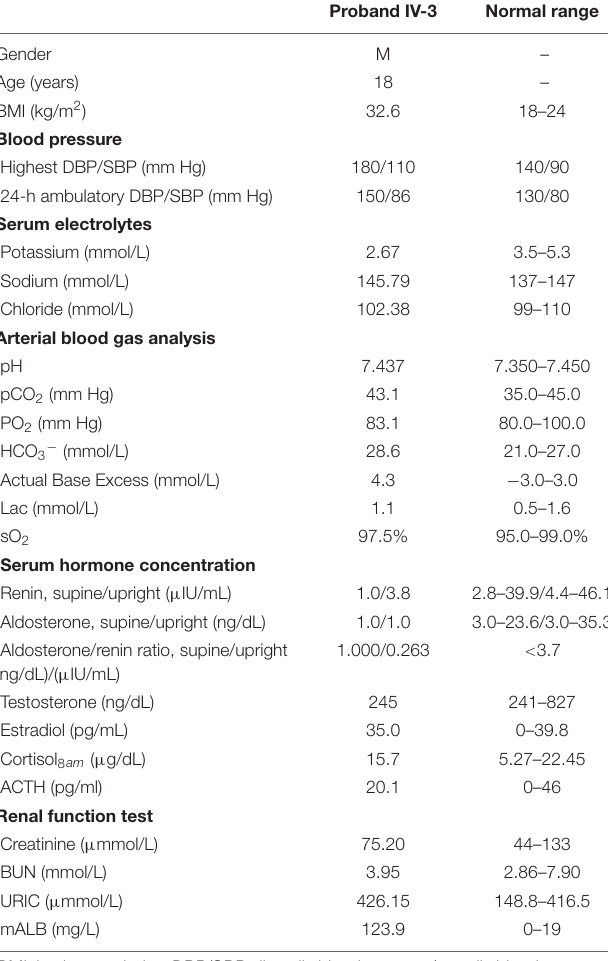
TABLE 1 | Clinical and biochemical data of the proband during hospitalization. Proband IV-3 Normal